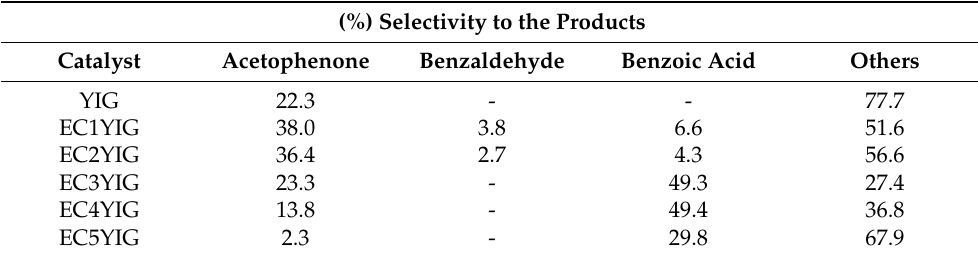
Table 2. Selectivity to the products of the oxidation of EB reaction in the presence of H 2 O 2 using acetone as solvent. Reaction conditions: EB to H 2 O 2 molar ratio of 1 using 1.3 mol of acetone as solvent, temperature of 50 ◦ C and a catalyst mass of 50 mg within 360 min of